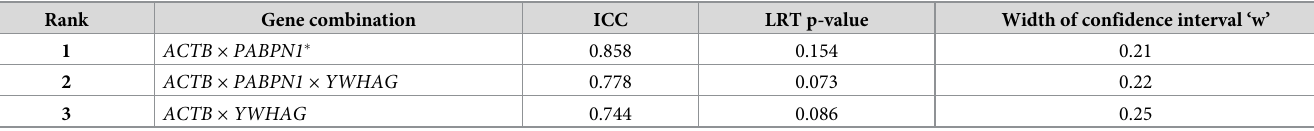
� Optimal reference gene combination with highest stability/reliability and no systemic variation by group. Reference gene combinations ranked in descending order of stability according to the 3-way linear mixed model. ICC = intraclass correlation coefficient; LRT p-value = Likelihood ratio test to determine if gene expression variation is due to systemic effects or their interaction with reference genes is significant. Group = treatment group. w: Confidence interval width ranks the ICC; a shorter width indicates greater accuracy. Since reference genes should be stable across groups without systemic effects, p-value for group/systematic effects (LRT p- value) for reference genes should be >